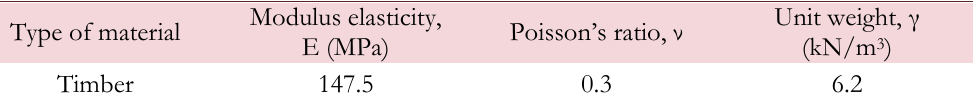
Table 1: Soil and concrete mechanical properties [22].